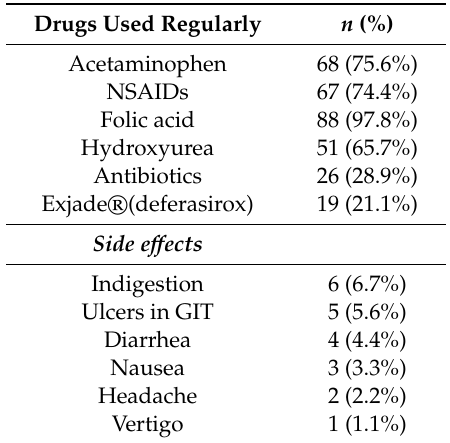
Table 3. Medications utilized at home and their adverse effects.